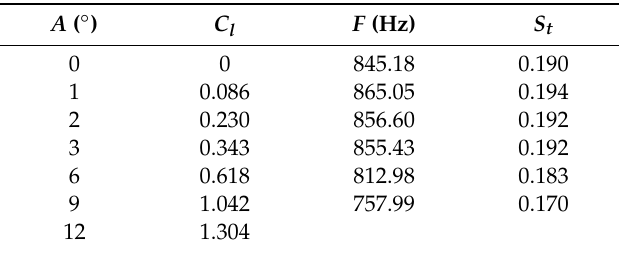
Table 6. E ff ects of α on wake vortex